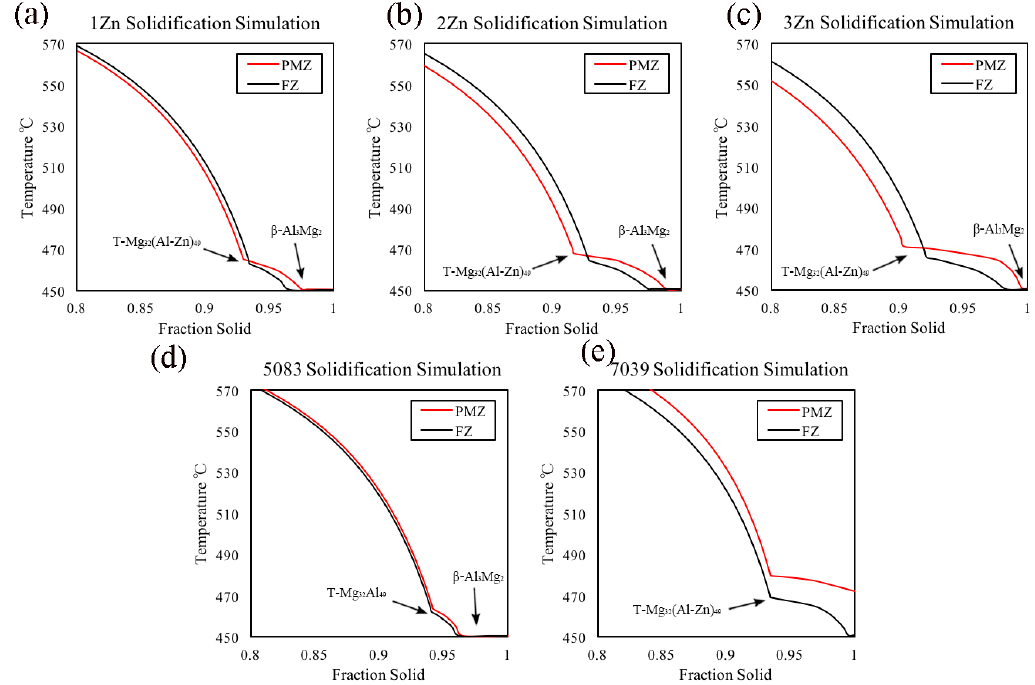
Figure 10. Solidification simulation results for all tested alloys: ( a ) Alloy 2, ( b ) Alloy 3, ( c ) Alloy 4, ( d ) Alloy 1, and ( e ) Alloy 5.